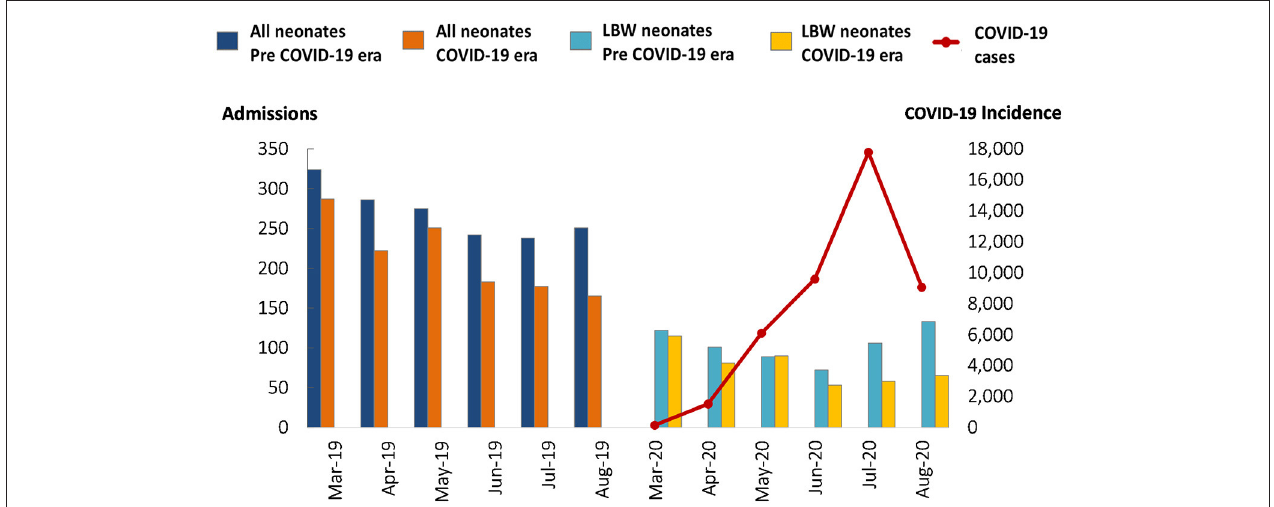
FIGURE 1 | Frequency of neonates admitted in TTH NICU during pre-COVID-19 and COVID-19 era. Pre-COVID-19 was defined as neonatal admissions from March 1st to August 31st, 2019. COVID-19 era was defined as neonatal admissions from March 1st to August 31st, 2020.